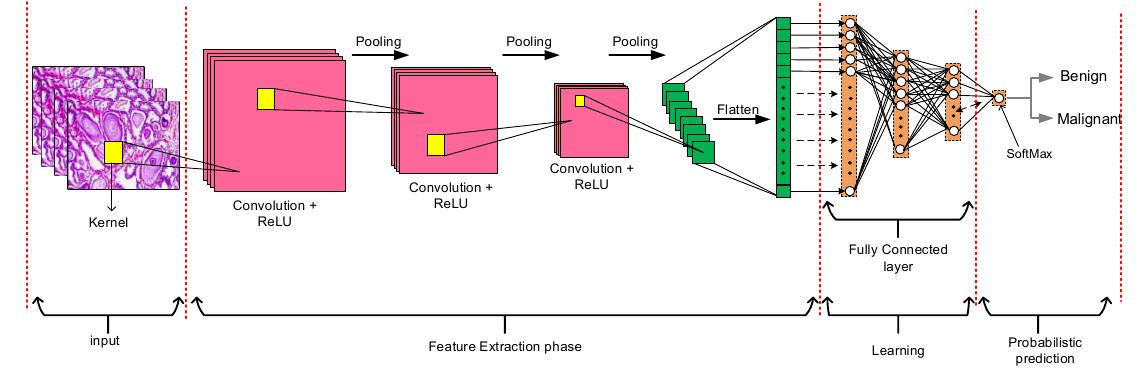
Figure 1. Convolutional Neural Networks